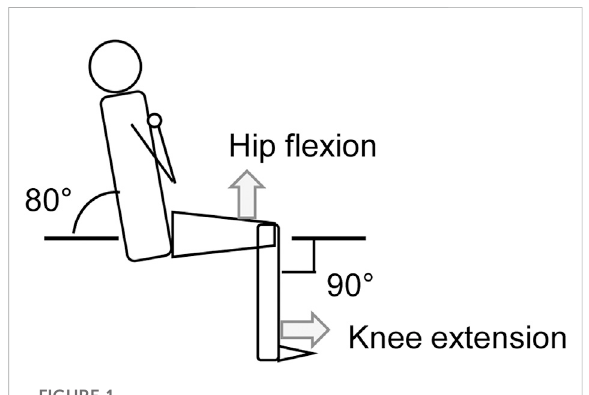
FIGURE 1 Schematic illustration of the posture for the maximal voluntary contraction torque measurements and isometric